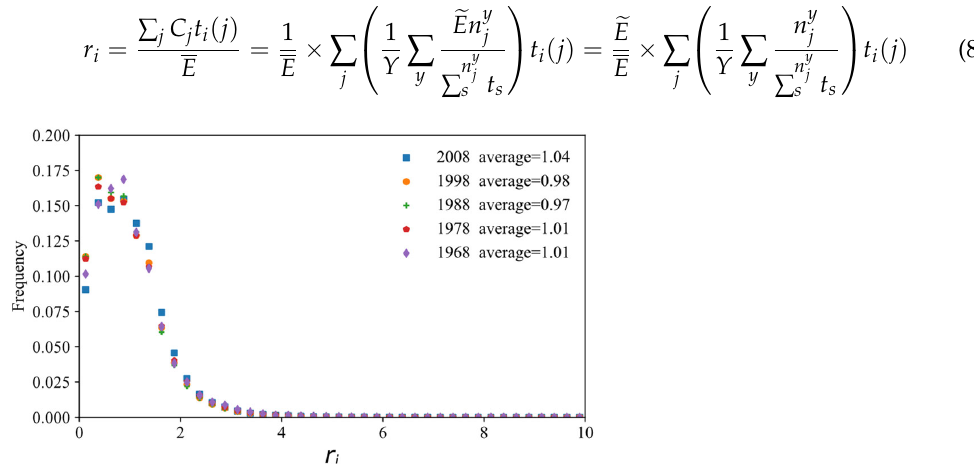
Figure 20. The distribution of 𝑟 (cid:3036) by year.